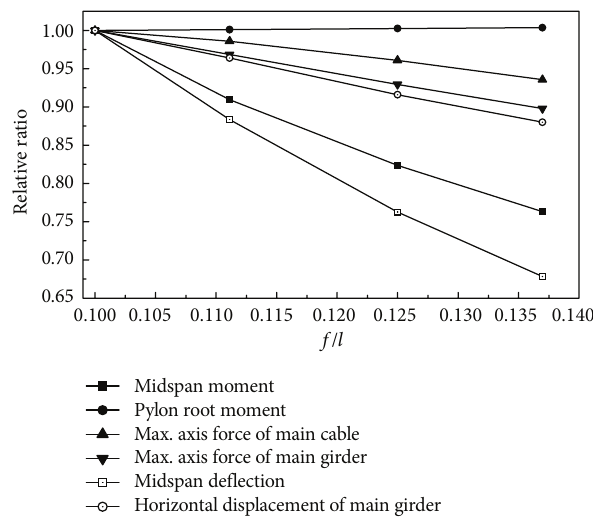
Figure 6: Effects of rise-span of main